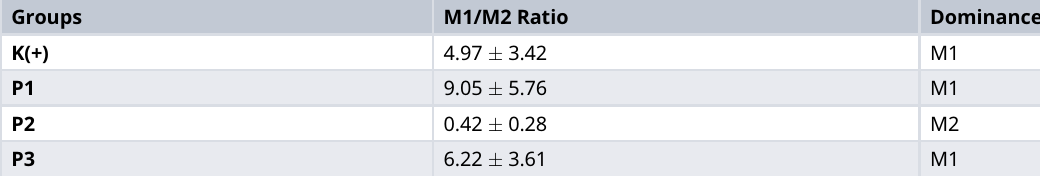
Table 5. Summary of M1 / M2 ratio in K (+), P1, P2 and P3.